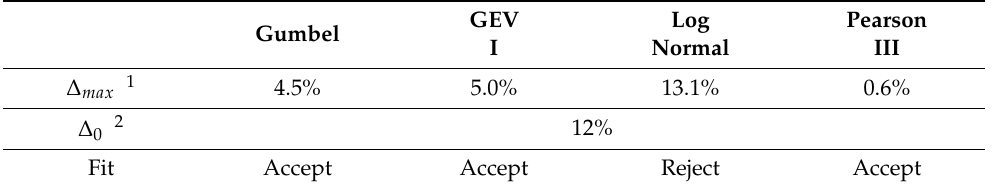
Table 3. Kolmogorov–Smirnov test at the Vinces station.